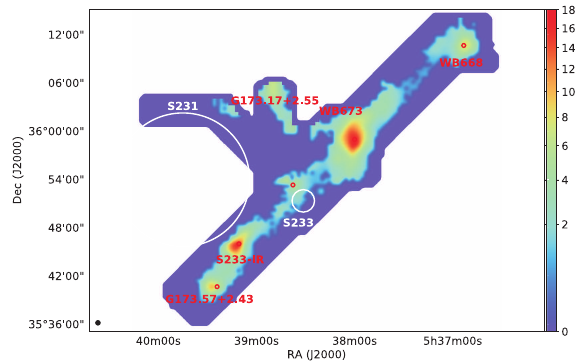
Figure 2. CS(2–1) integrated emission in the WB673 filament. Col- orbar shows intensity scale in K kms −1 . White circles outline S231 and S233 H ii regions from the Sharpless catalogue Sharpless (1959). Red circles show positions where analysis of the methanol emission was done, see Sect. 4. Pixels with signal-to-noise ratio higher than 3 are shown on the map. Beam size 38.5 ′′ is in the left low corner. Bicubic interpolation is used to produce the map. The intensity scale uses a square-root stretch.